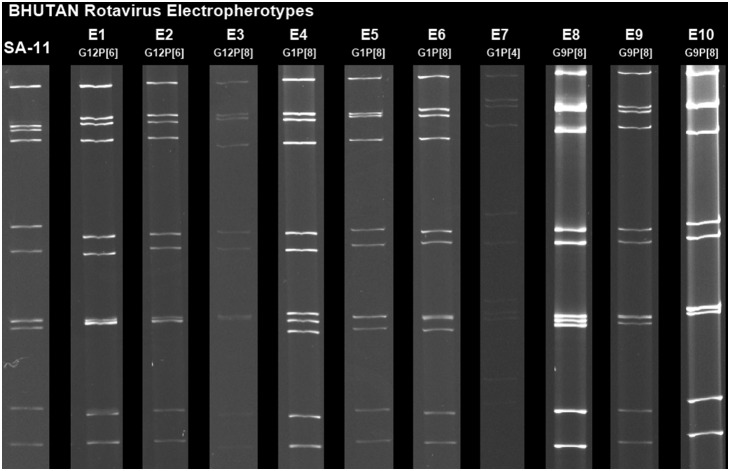
Electropherotypes of rotaviruses identified in Bhutan.On the extreme left, SA-11 indicates the electropherotype of strain Sa-11, which was used as a marker in each electrophoresis run. In total, 10 electropherotypes were identified, E1–E10. The genotype of each electropherotype is shown below the electropherotype. With the exception of E7, the electropherotypes had long patterns. Among five strains from Mongar, three were electropherotype E4, one E10, and one was untypable.